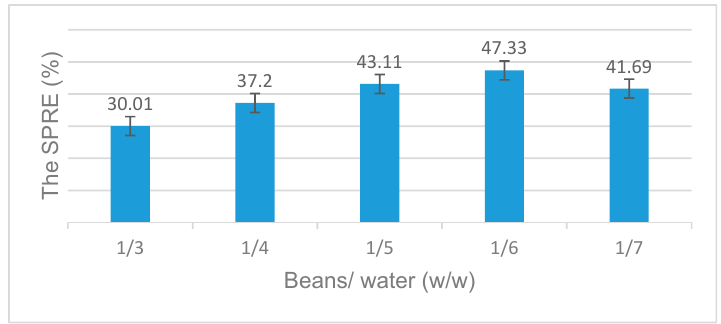
Figure 2. The effect of beans/water ratio on the SPRE.